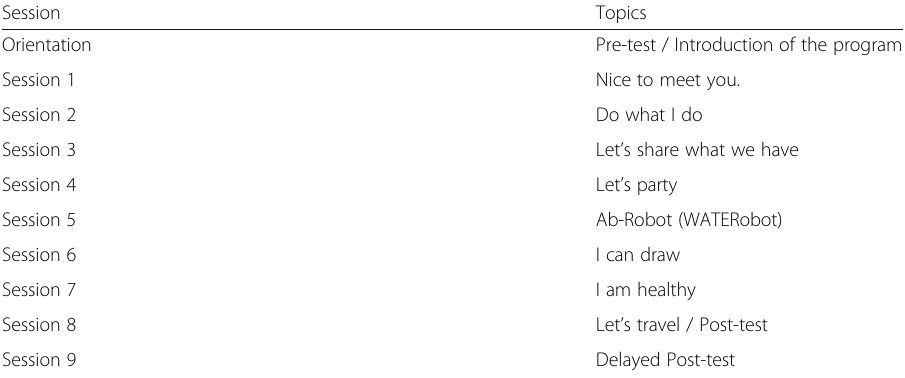
Table 2 The topics of the sessions